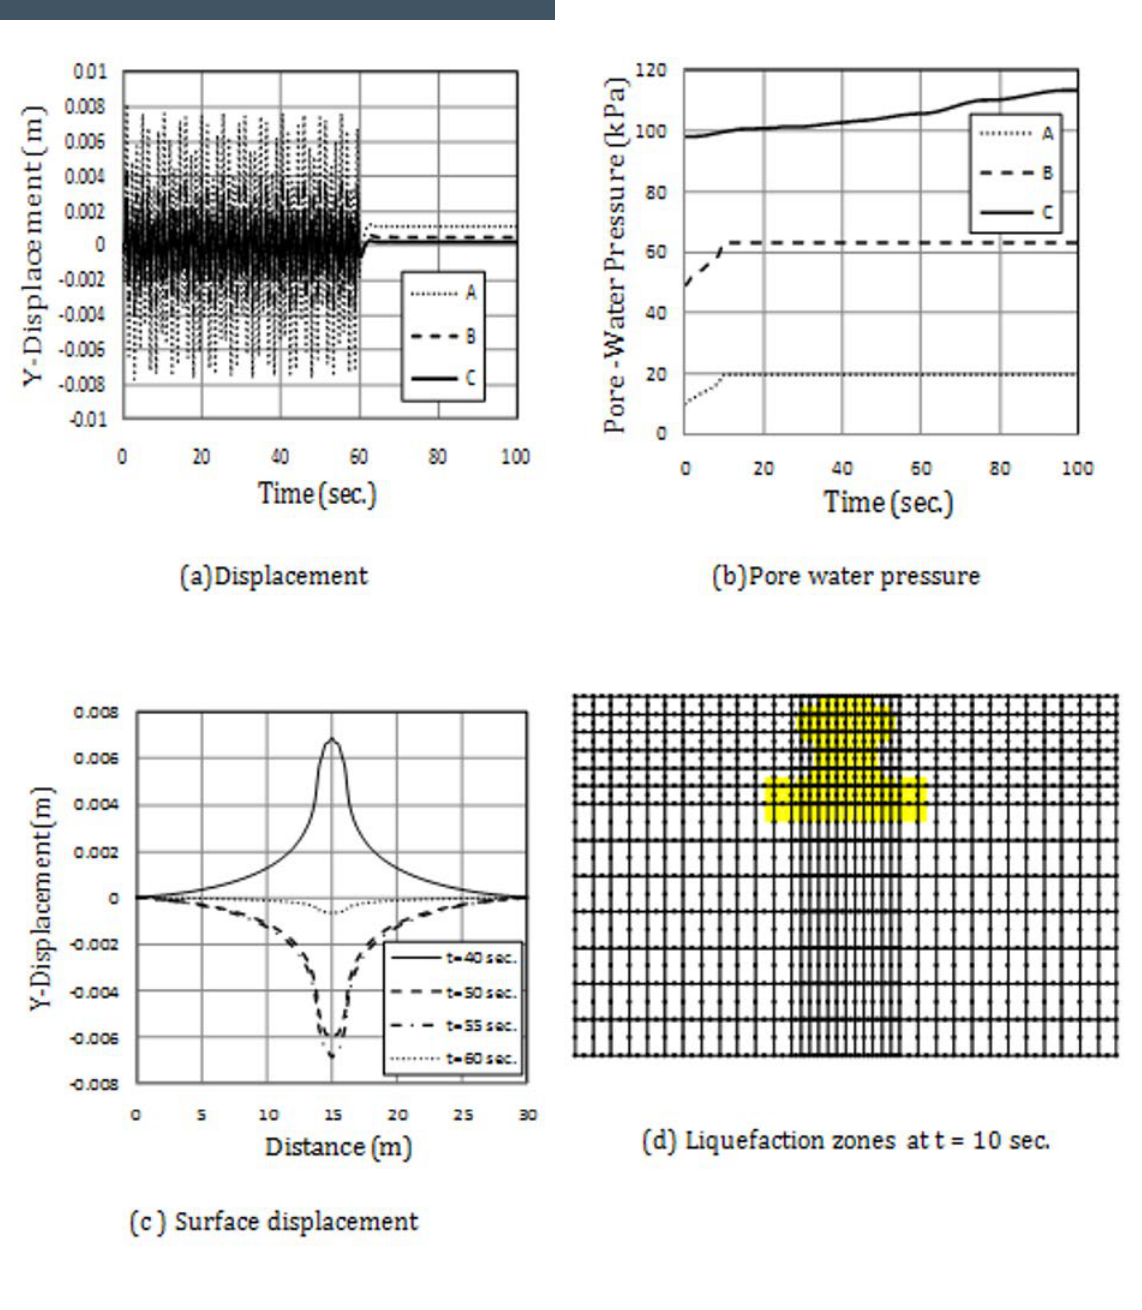
Figure 12. Dynamic response of the foundation to harmonic load, a